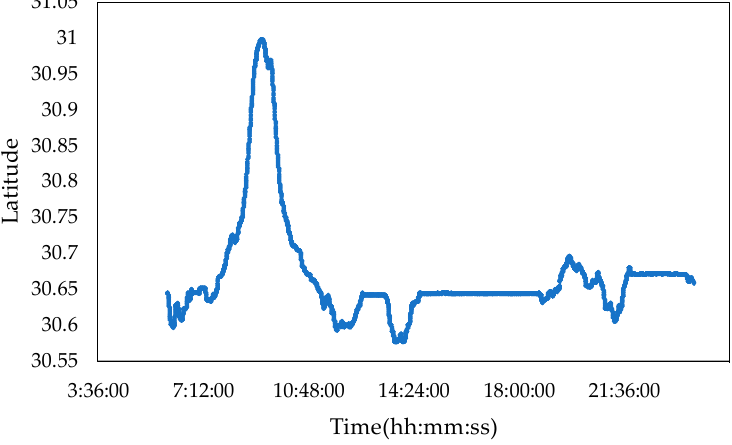
Figure 5. The time series graph of the longitudes of trajectory points of the shadowed taxi trajectory.